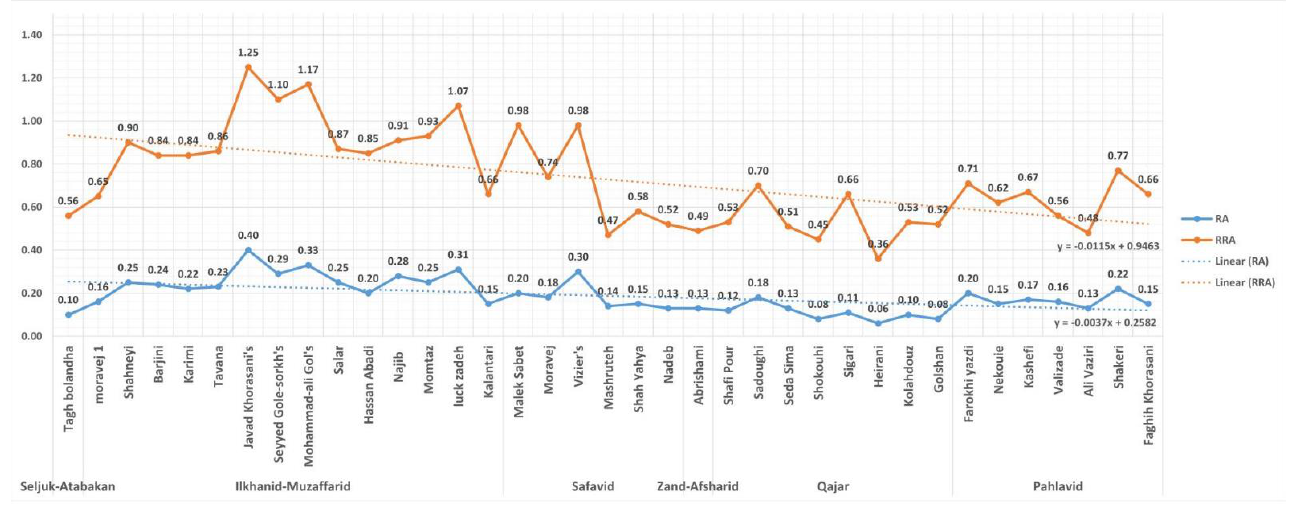
Figure 10. Relative Asymmetry ( RA ) and Real Relative Asymmetry ( RRA ) results and trendlines for the 37 houses, presented chronologically by era.